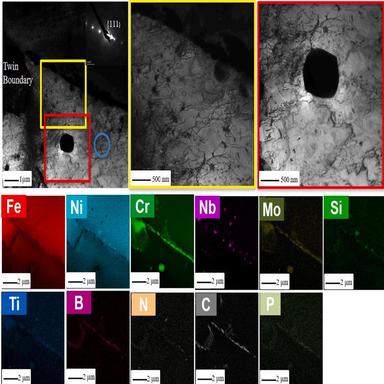
BF TEM of Alloy 709 after Creep at 800 ◦C and 70 MPa Showing Dislocations Interactions with Precipitates and Chemical Maps Showing Enrichment and Depletion at Twin Boundaries.